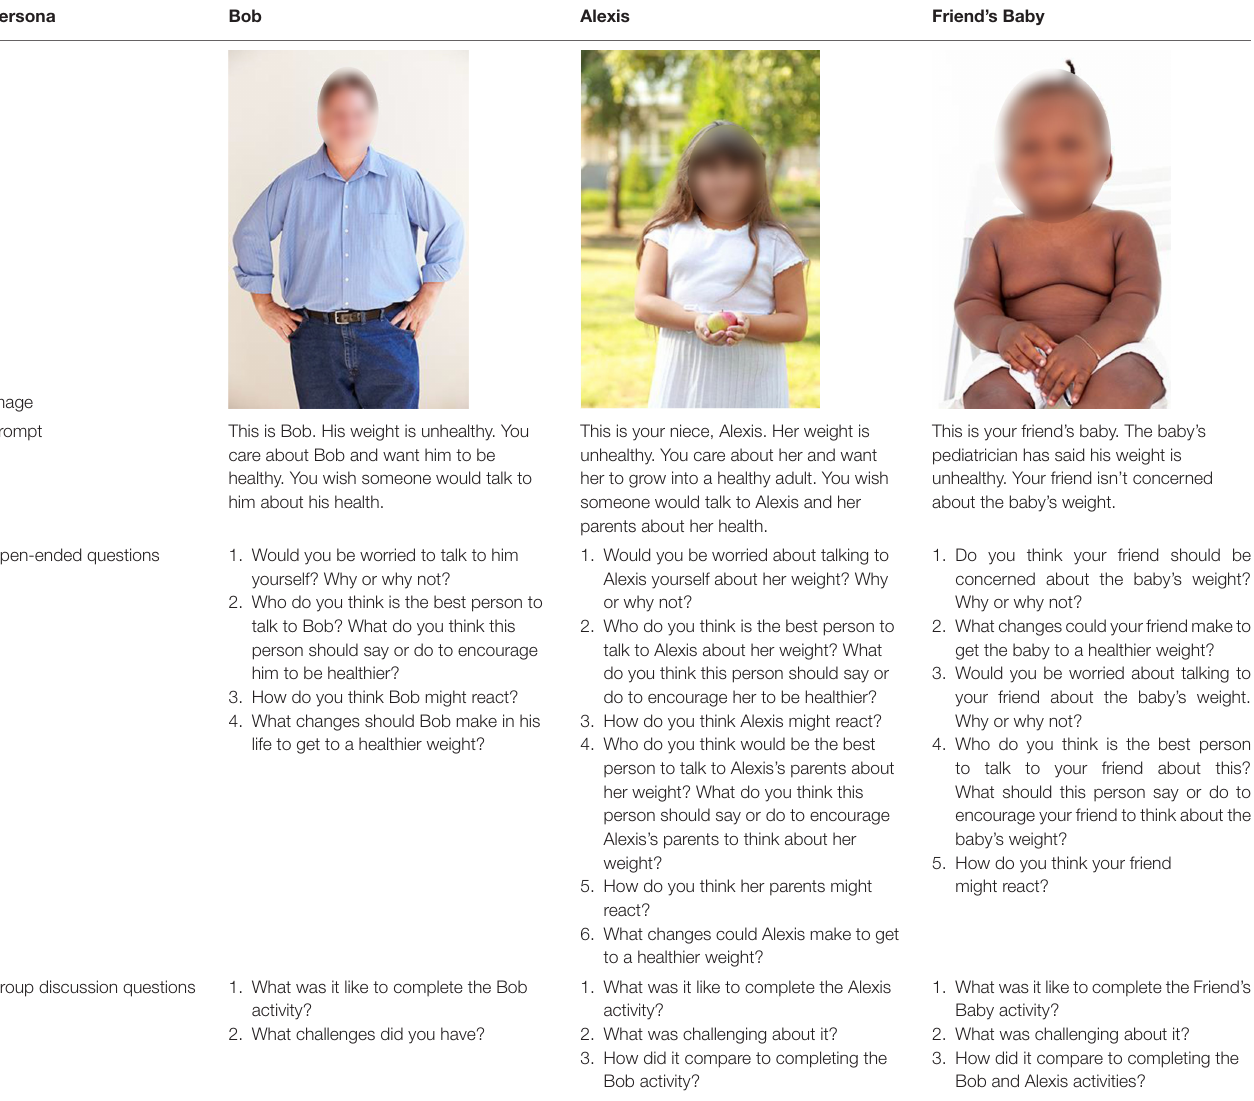
TABLE 1 | Human-centered design activities completed in revelation: persona and empathy map activities, discussion prompts, and group discussion questions.